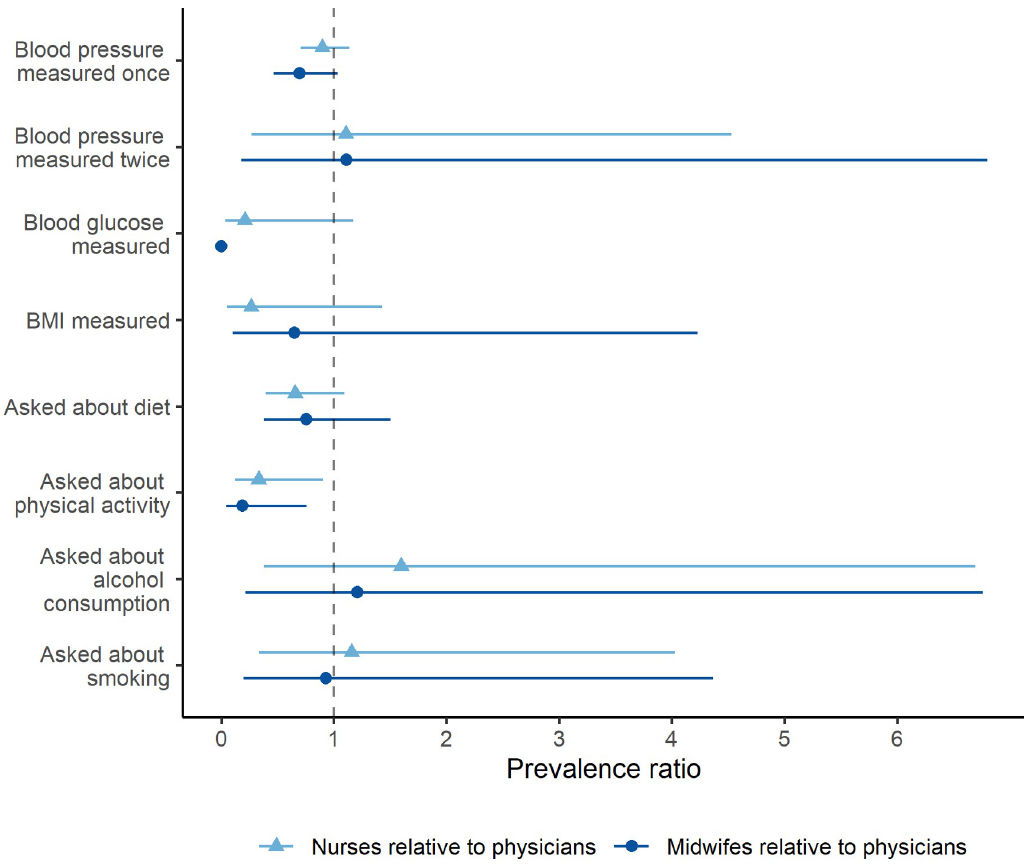
Fig 2. Association between clinician cadre and CVD care actions based on univariate Poisson regression. Coefficients are presented as prevalence ratios relative to physicians. Error bars represent 95% confidence intervals. There is no 95% confidence interval for the coefficient on midwives measuring blood glucose since no midwives in the sample measured blood glucose (resulting in perfect prediction and a confidence interval of 0 width).